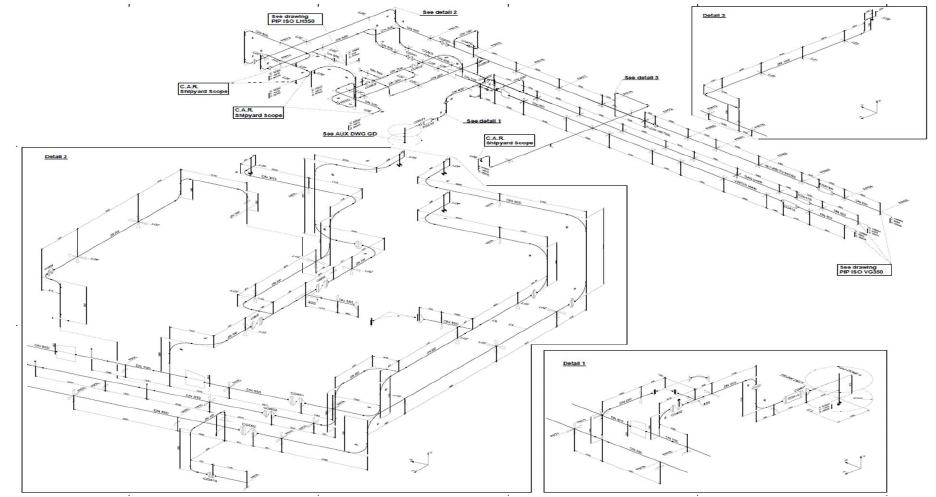
Figure 4. ISO drawing of liquid main of liquefied natural gas (LNG) piping system used for case study.